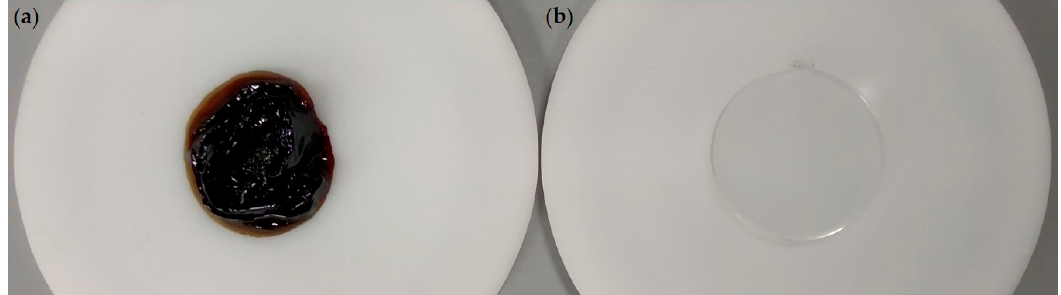
Figure 11. ( a ) PC sample stored in the center after complete failure after 987 h; and ( b ) unaged PC sample.